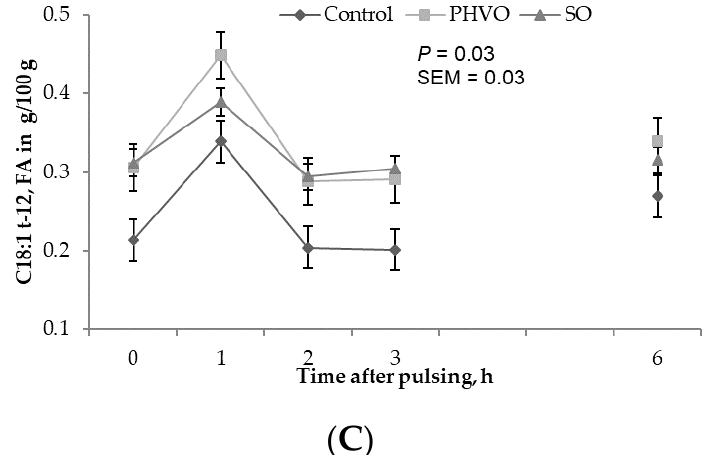
Figure 3. Time variations of C18:1 trans fatty acids in plasma from cows subjected to ruminal pulses of control, partially hydrogenated vegetable oil and soybean oil. ( A ) C18:1t-4; ( B ) C18:1t-5; and ( C ) C18:1t-12. Blood samples were collected prior to ruminal pulse (0 h; 09:00) and 1, 2, 3 and 6 h after ruminal pulse. SEM = standard error of the mean. Means are pooled across days for each cow. p ‐ value represents the effect of sampling time.